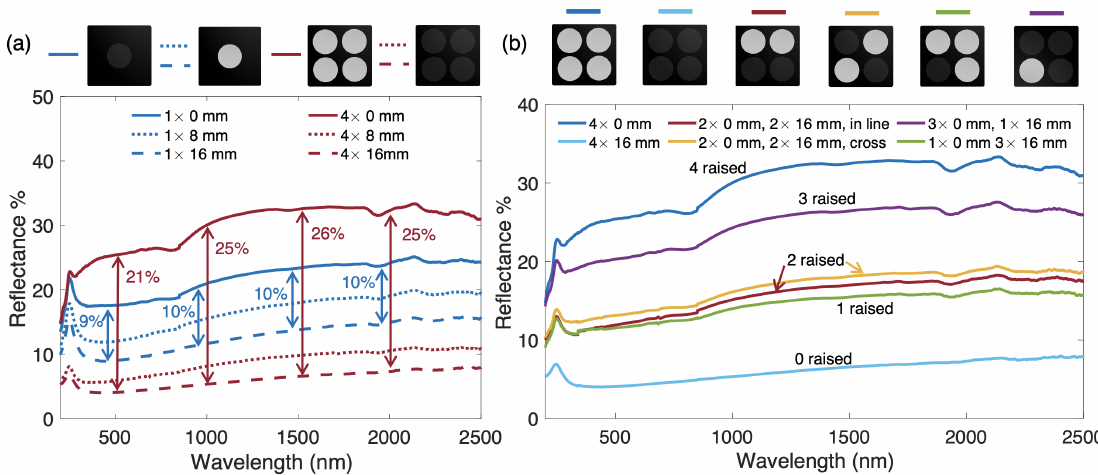
Figure 6. Reflectance spectra for multi-piston structures. ( a ) Spectra comparison for single piston and 4 × grouped piston structures at various displacements. ( b ) Spectra comparison for 4 × grouped piston structure with various combinations of piston positions. All pistons have diameter D = 3.20